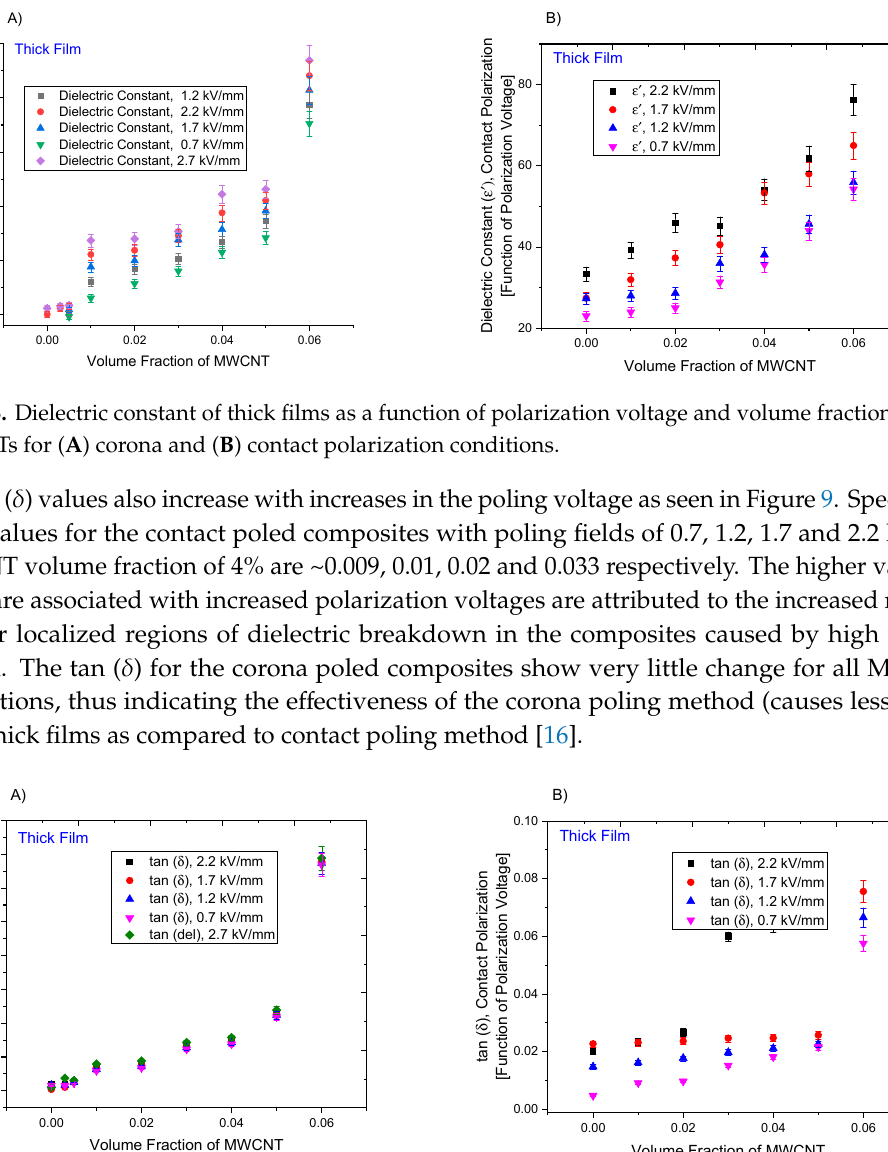
14 Figure 10. Piezoelectric strain coefficient of thick films as a function of polarization temperature and volume fraction of MWCNTs for ( A ) corona and ( B ) contact polarization conditions. The ε ’ , values show a similar increase with the poling temperature for the three phase thick film composites. Figure 11 shows the change in ε ’ values with the poling temperature varying from 45–75 ° C. For all volume fractions of MWCNTs the dielectric constant is higher at higher poling temperatures. For example, in the case of corona poling and for a MWCNT volume fraction of 4% the ε ’ values for poling temperatures of 45, 55, 65 and 75 ° C are ~57, 71, 81 and 95, respectively. For the -0.01 0.00 0.01 0.02 0.03 0.04 0.05 0.06 0.07024681012